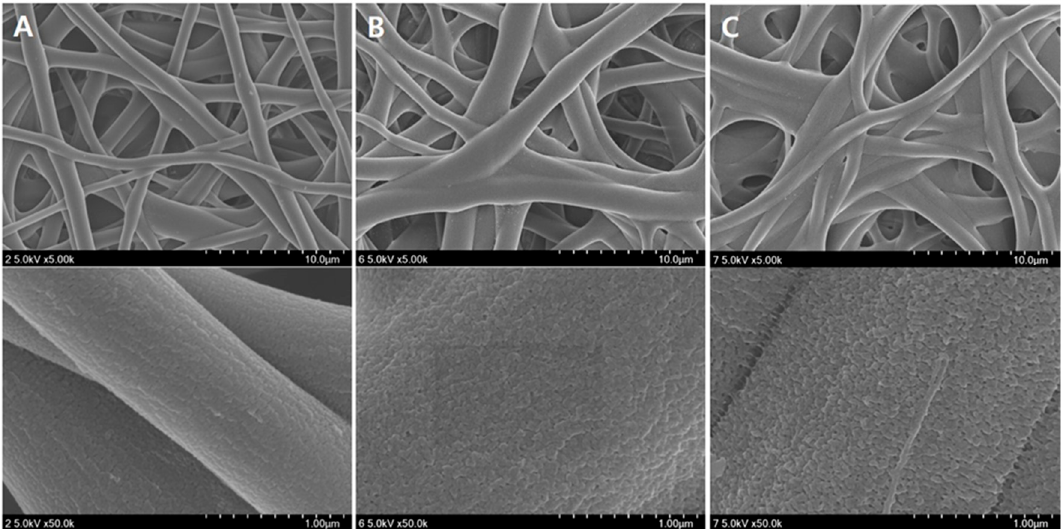
Figure 2. Field emission scanning electron microscope (FE-SEM) images of saponified PVA nanofiber mats obtained at different temperatures: ( A ) 25 °C; ( B ) 35 °C; and ( C ) 45 °C. The quantities of the reagents in the saponification solution (NaOH = 10 g, Na 2 SO 4 = 10 g, MeOH = 10 g, and H 2 O = 100 g) and the reaction time (12 h) were kept constant. Polymers 2016 , 8 , 376